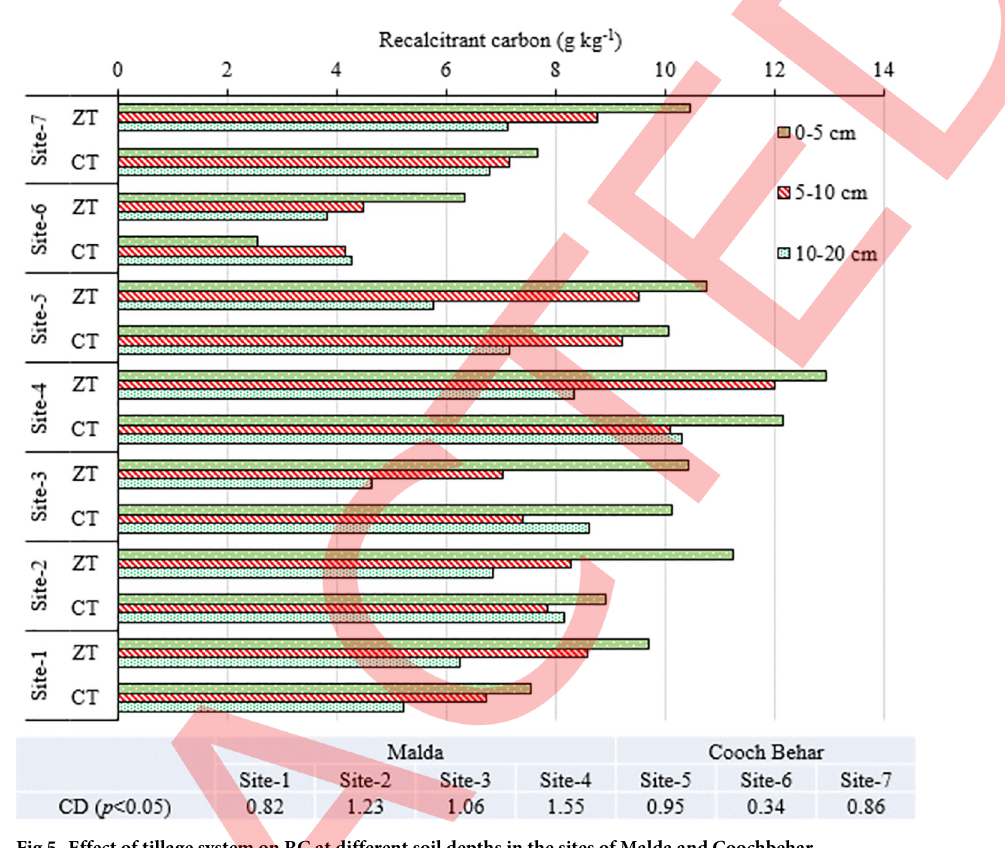
Fig 5. Effect of tillage system on RC at different soil depths in the sites of Malda and Coochbehar.